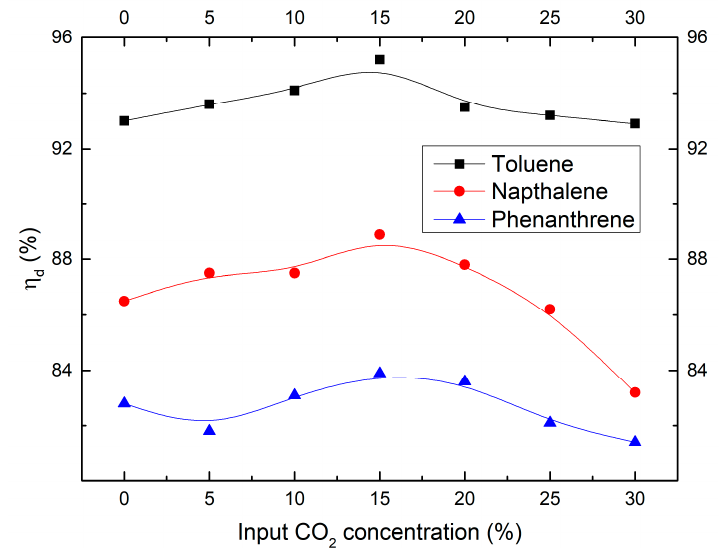
Figure 9. Effect of CO 2 concentration on destruction efficiency.